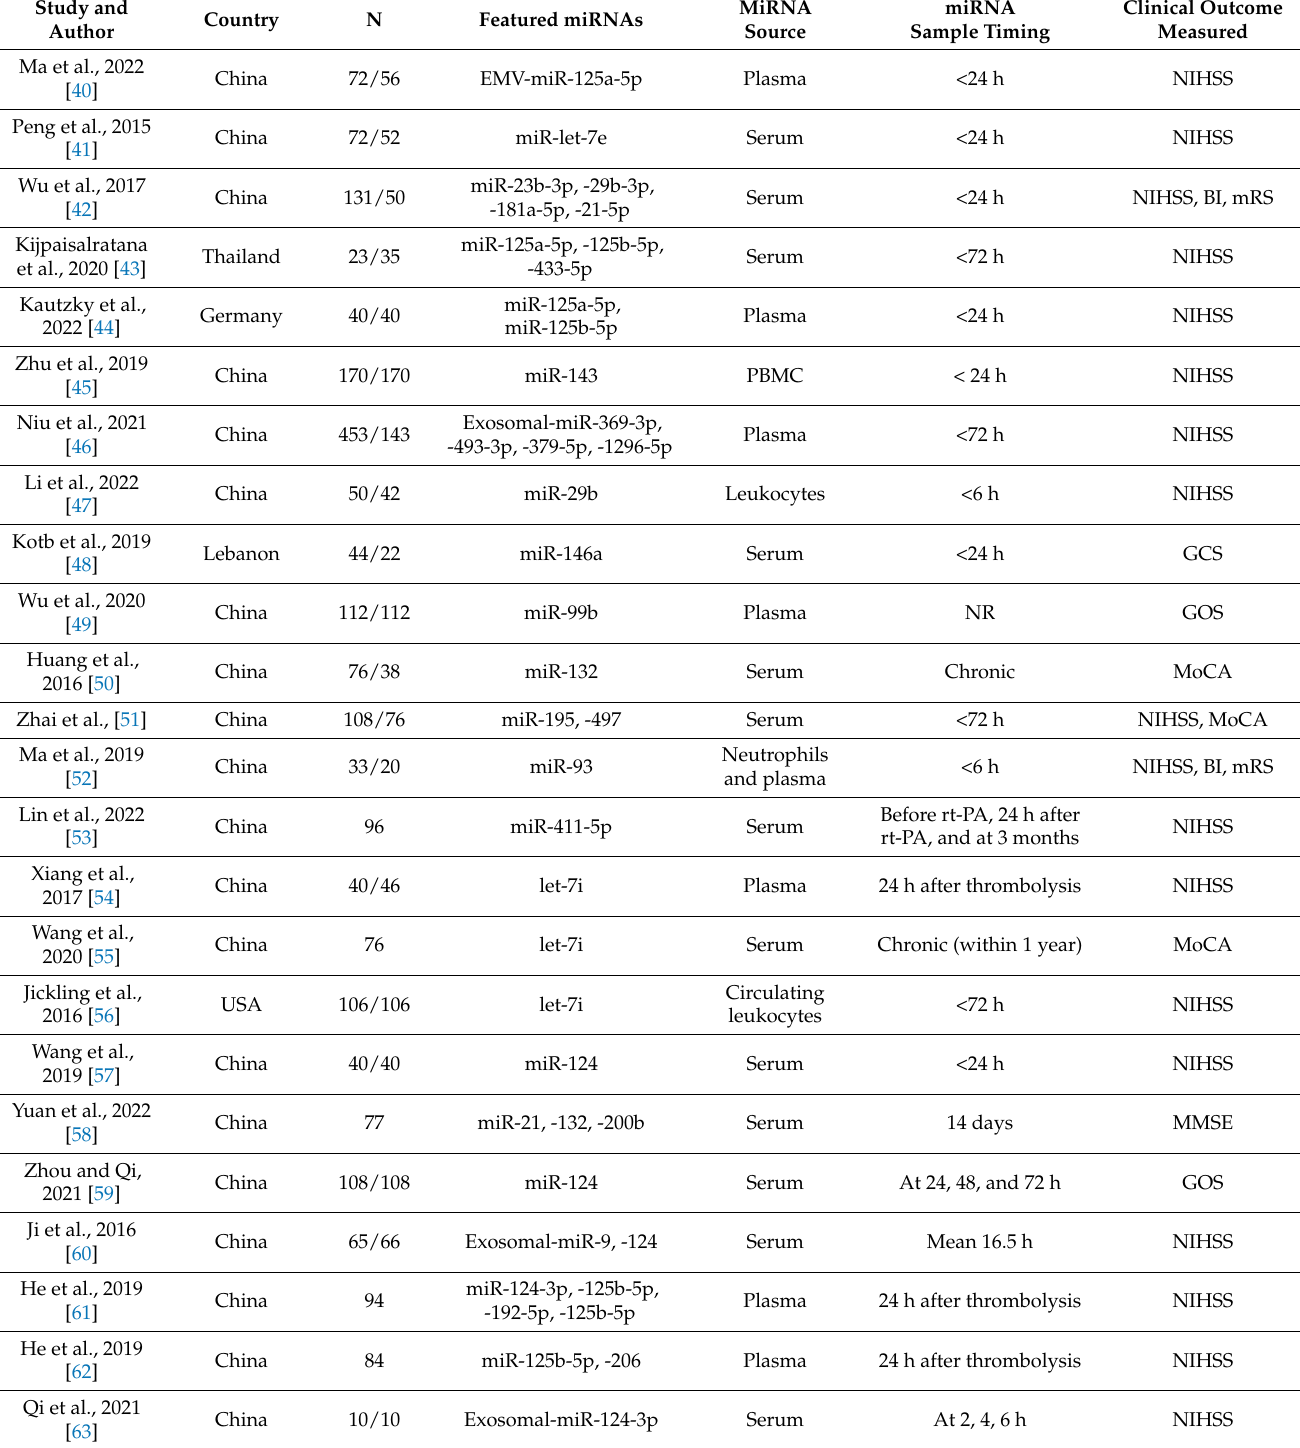
Table 1. Overview of identified circulating miRNAs in blood specimens which provide prognostic value in stroke